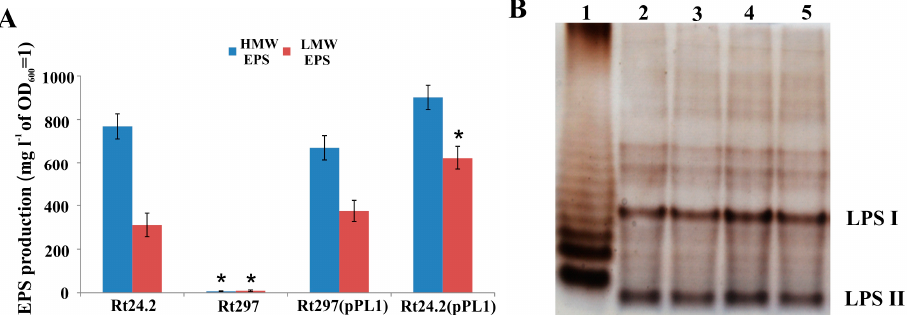
Figure 4. Production of high- (HMW) and low-molecular weight (LMW) exopolysaccharide EPS by wild-type strain R. leguminosarum Rt24.2 and several derivatives ( A ). The given values are averages ± SD of three independent experiments with three biological replicates for each strain analyzed. * The amount of EPS produced by the tested strains was significantly different from that produced by the wild-type strain Rt24.2 ( p < 0.05, Student’s t -test). ( B ) Silver-stained Tricine SDS-PAGE profiles of LPS from Rt24.2 and several derivatives. The amount of LPS loaded into each well was 1 μ g. Lanes: 1, LPS of Salmonella enterica sv. Typhimurium (Sigma, St. Louis, MO, USA); 2, LPS of Rt24.2; 3, LPS of Rt297; 4, LPS of Rt297(pPL1); and 5, LPS of Rt24.2(pPL1). LPS I, high-molecular weight LPS corresponding to smooth LPS; LPS II, low-molecular weight LPS corresponding to rough LPS.